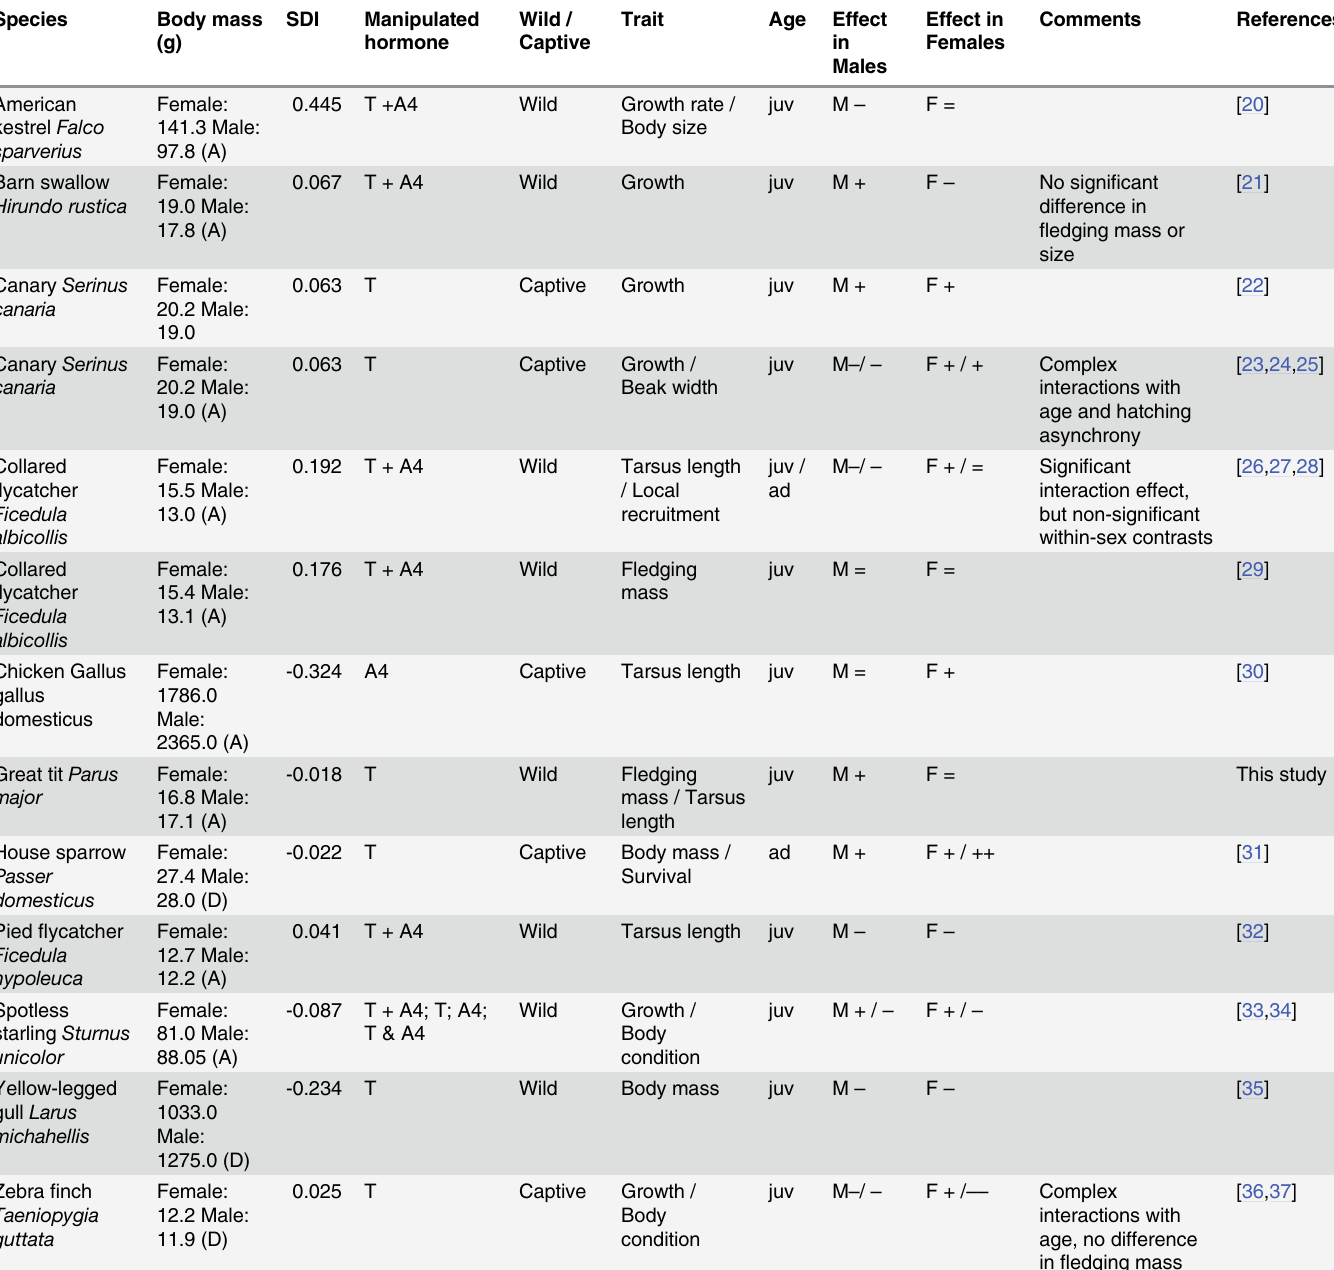
Table 1. Sex-specific effects of yolk androgen manipulation on growth and morphology in birds. Species Body mass SDI Manipulated Wild / Trait Age Effect (g) hormone Captive in